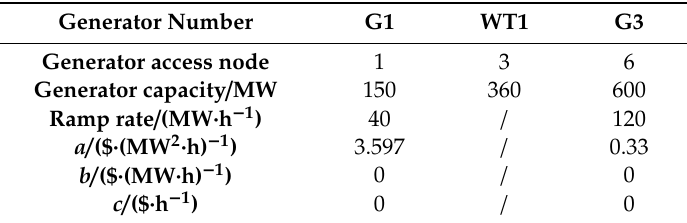
Table A2. Garver-6 system generator data.